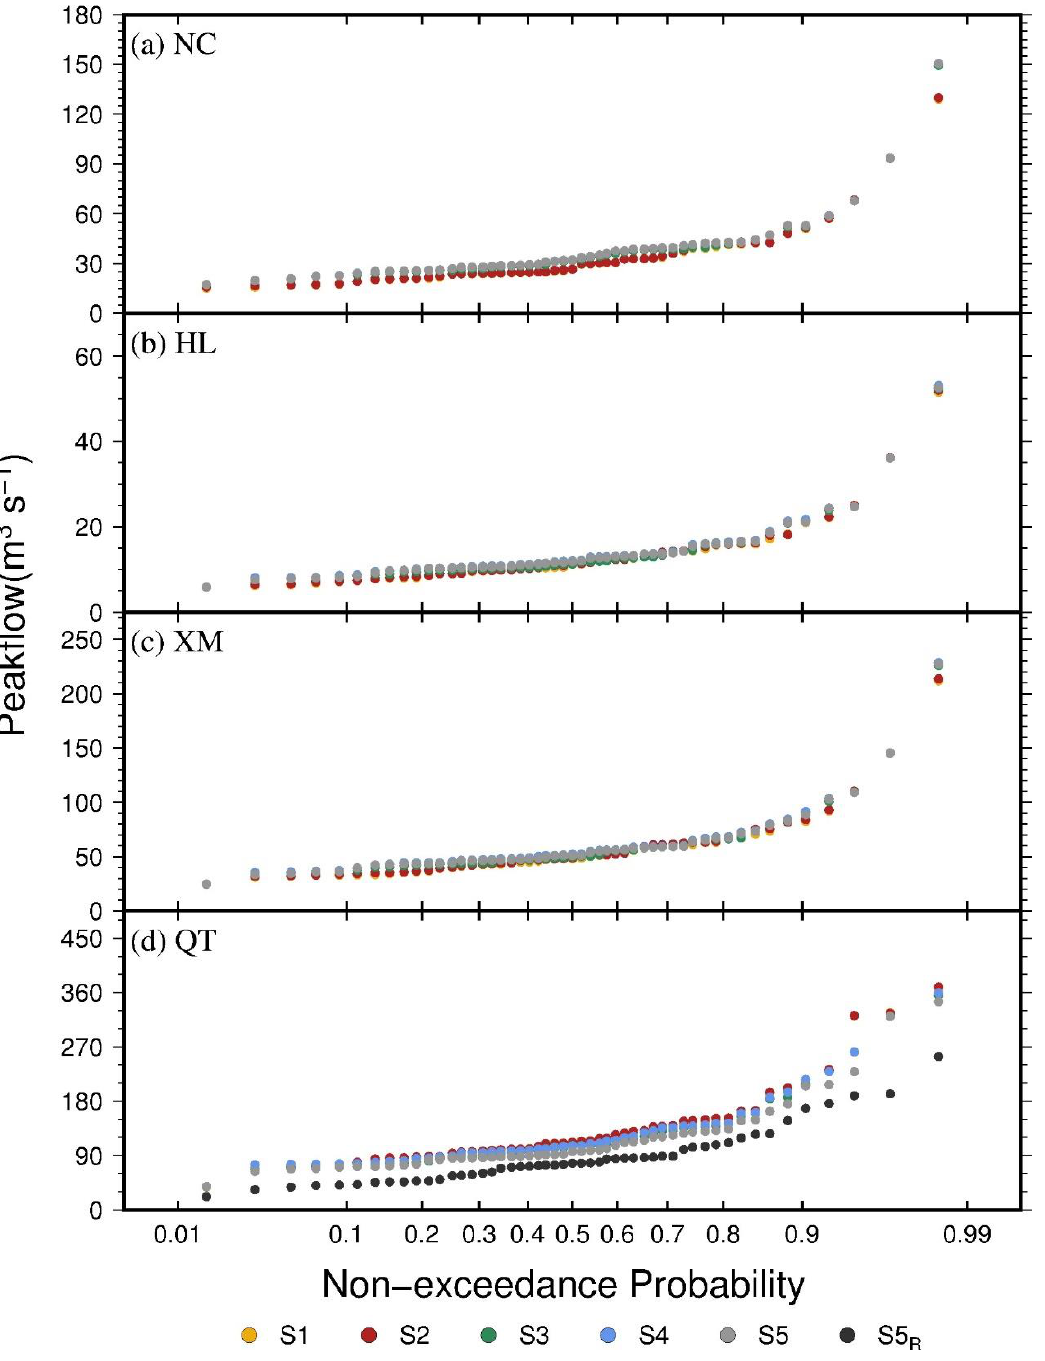
Figure 8. Non-exceedance probability of annual maximum peakflow for six scenarios at NC ( a ), HL ( b ), XM ( c ), and QT ( d ). ( b ), XM ( c ), and QT ( d